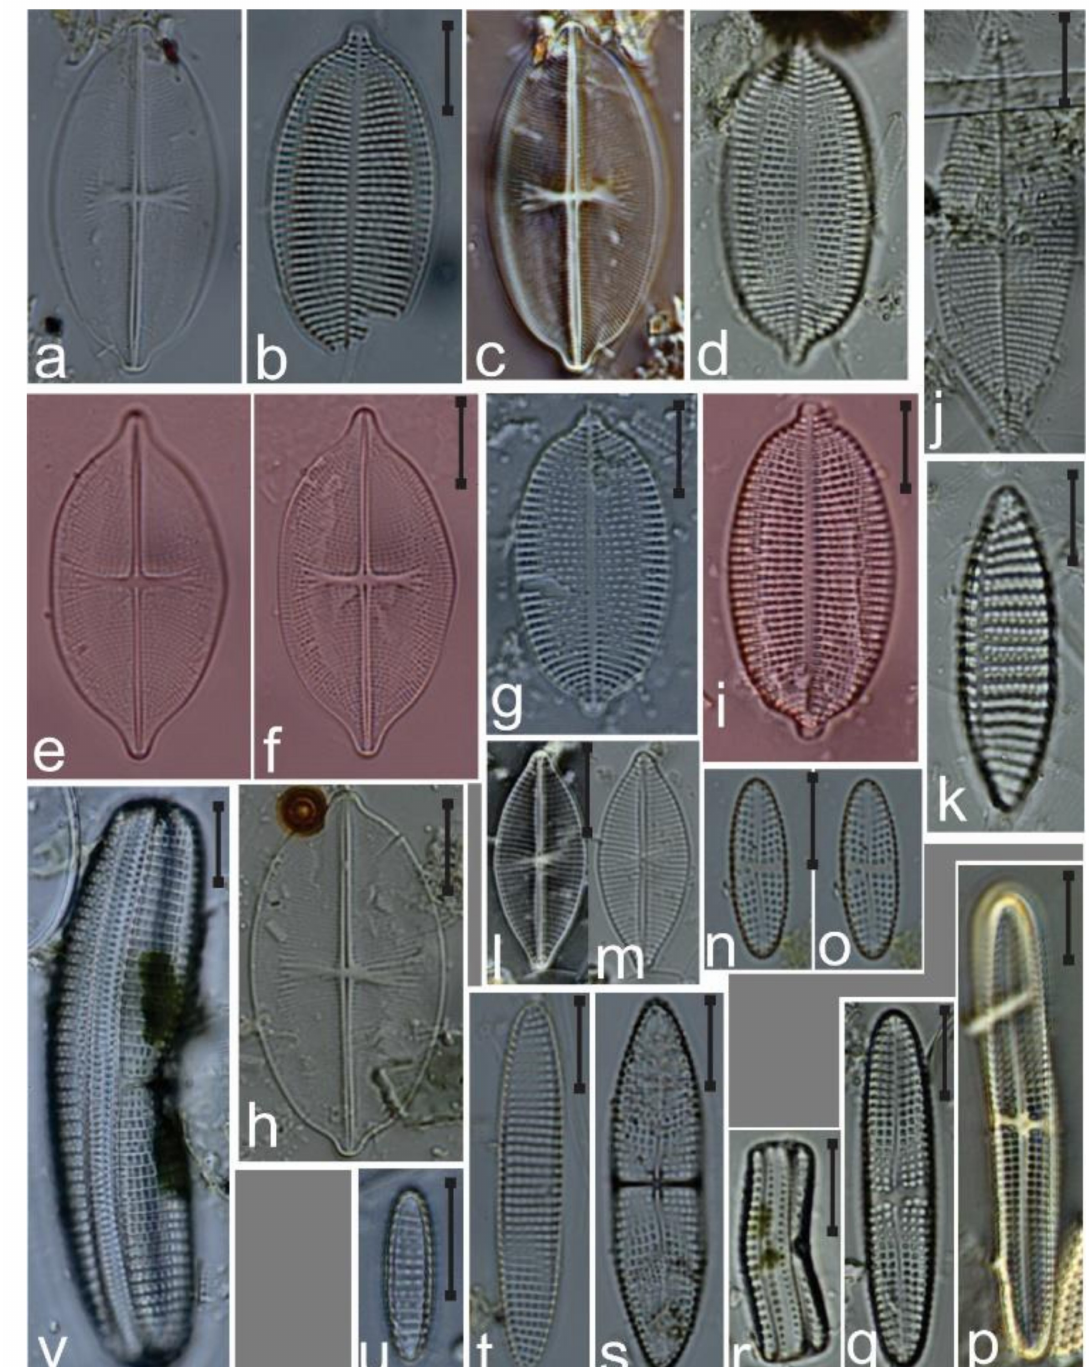
Figure 22. ( a – i ) Achnanthes citronella ; ( j , l , m ) A . cf. fimbriata ; ( k , v ) A. subconstricta ; ( n , o , u ) A. parvula ; ( p , q ) A. groenlandica var. phinneyi ; ( r , t ) A. pseudogroenlandica ; ( s ) A. yaquinensis . Scale bar = 10 µ